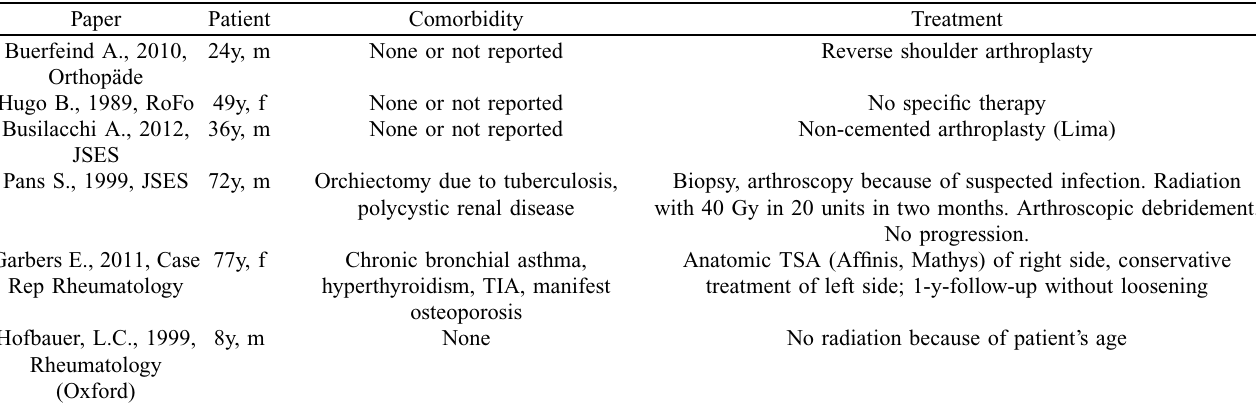
Table 3. Overview of the PubMed listed shoulder-specific case-reports of Gorham-Stout syndrome using the following search: ‘‘Gorham’’ and